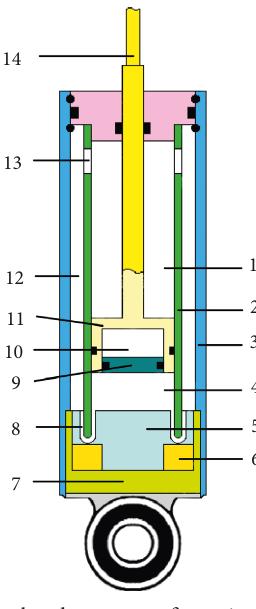
Figure 11: Twin-tube damper configuration with coil located stationary relative to the housing: 1, rebound chamber; 2, inner tube; 3, outer tube; 4, compression chamber; 5, core element; 6, coil; 7, cup-shaped end member; 8, gap; 9, floating piston; 10, accu- mulator; 11, piston; 12, reservoir; 13, openings; 14, piston head